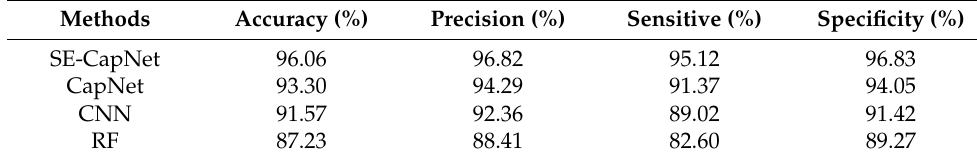
Table 4. Comparison of precision index